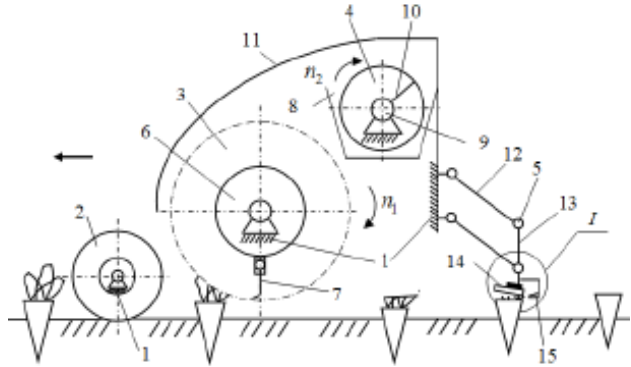
Figure 2. Constructive scheme of the improved machine for haulm cutting: 1—chassis frame;